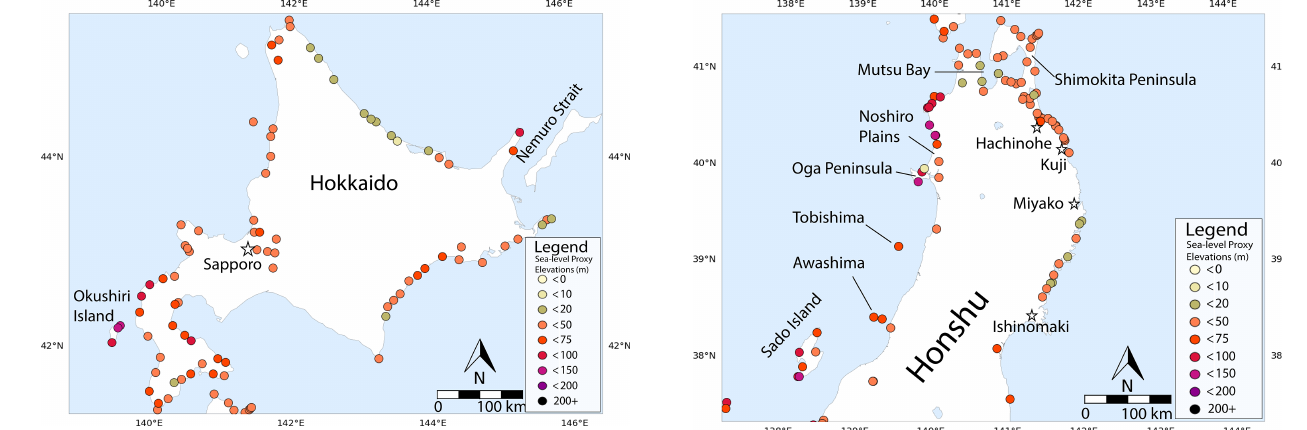
descriptions are provided.